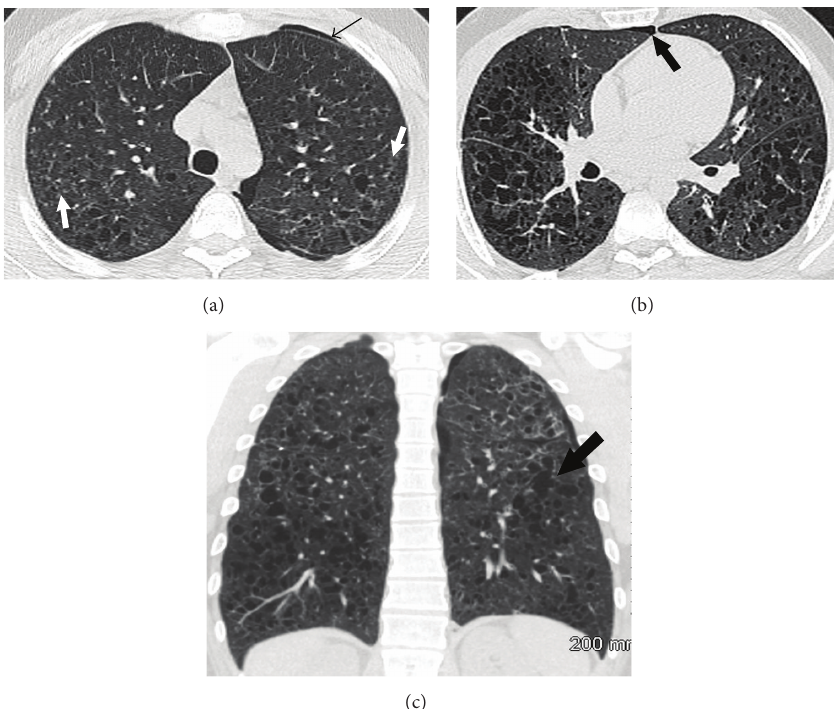
Figure 1: (a) Axial CT scan of the chest with lung window settings at the level of the upper trachea demonstrates multiple bilateral thin-walled cysts and a few ill-defined centrilobular nodules (white arrows). Note a small left pneumothorax (thin black arrow). (b) Axial CT scan of the chest with lung window settings demonstrates bilateral thin-walled cysts, some with bizarre shapes such as in the left lower lobe. Note a small residual right-sided pneumothorax (arrow). (c) Coronal CT reformats with lung window settings demonstrate bilateral lung cysts, some with bizarre shapes (arrow) involving mainly the mid and upper lung zones with relative sparing of the costophrenic